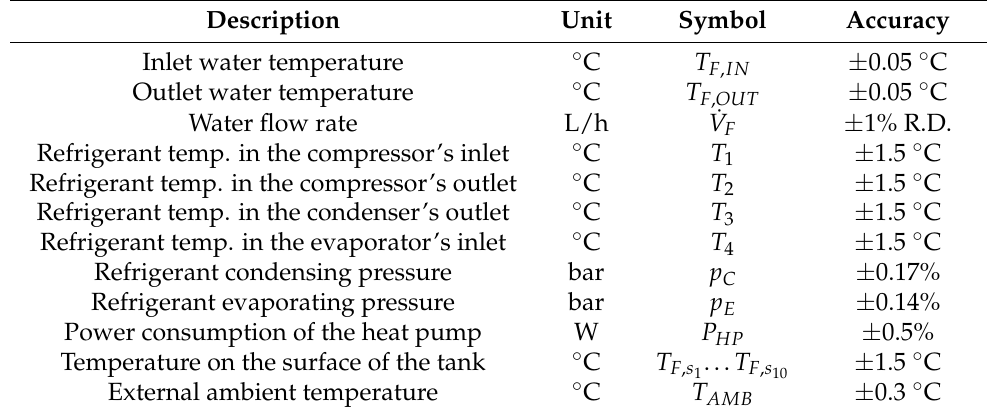
Table 3. Tank stratification experiments. Measurements taken and recorded every